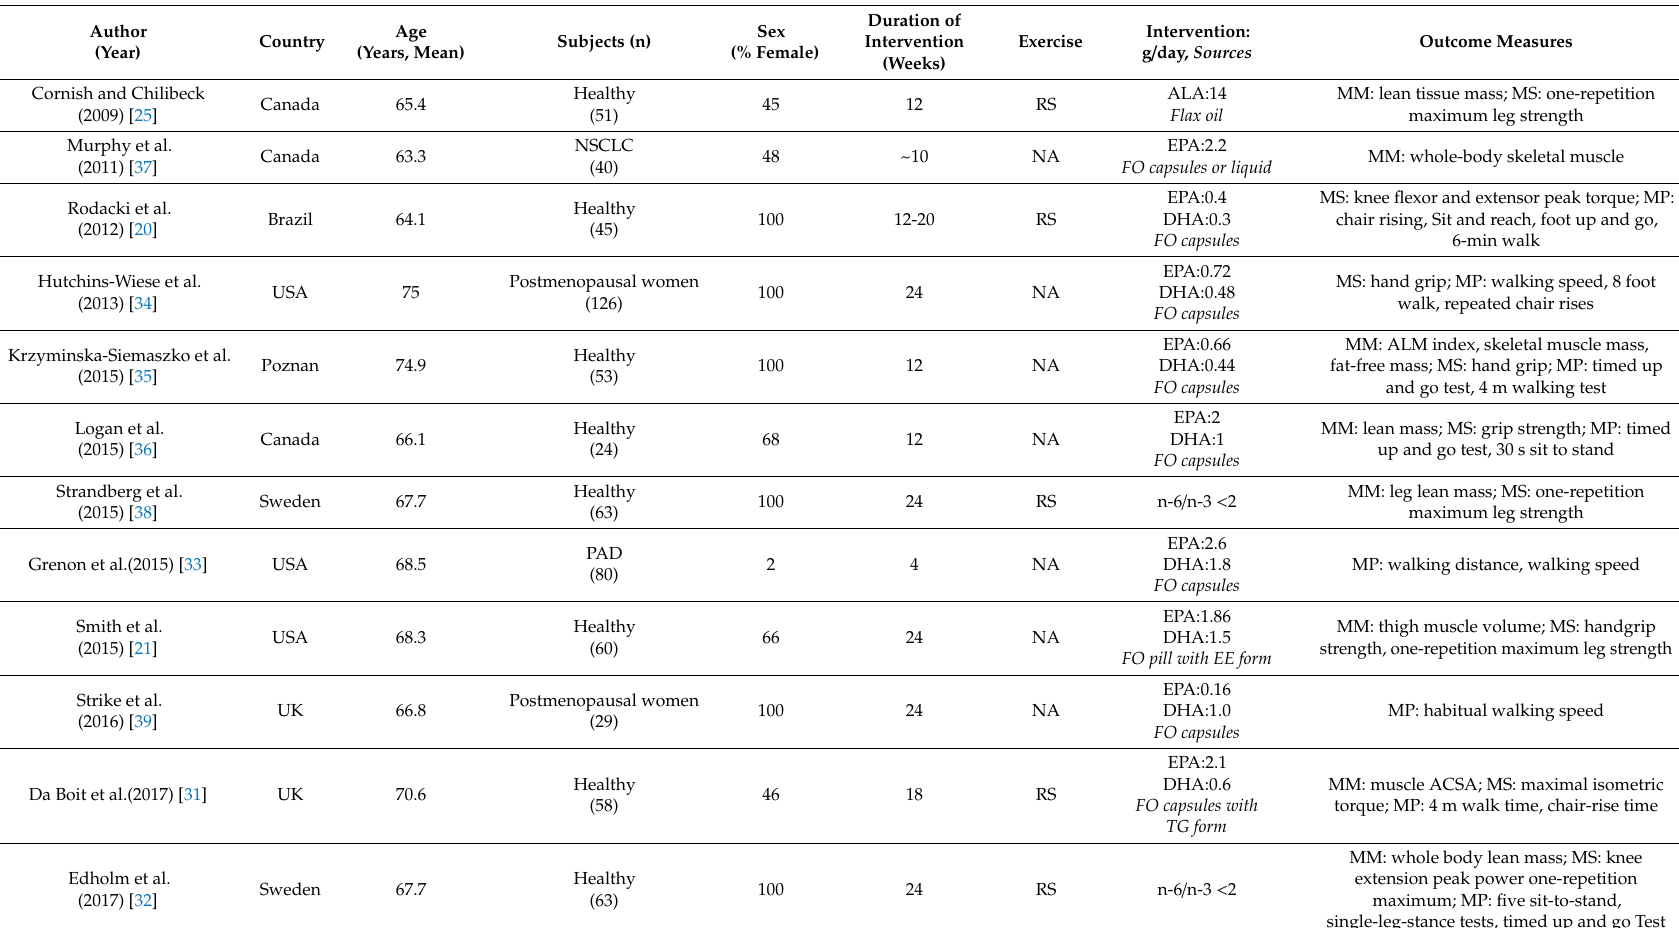
Table 1. Study characteristics of the included